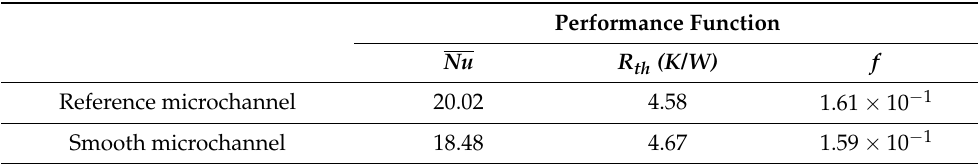
Table 4. Performance comparison between reference and smooth wavy microchannels.